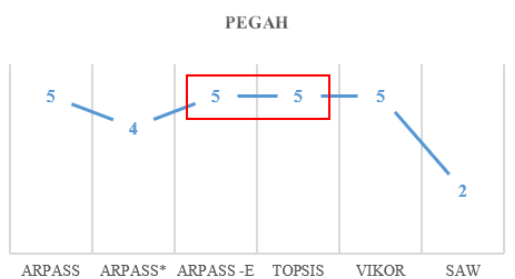
Figure 11. Rank fluctuation of Mihan in the six investigated methods.